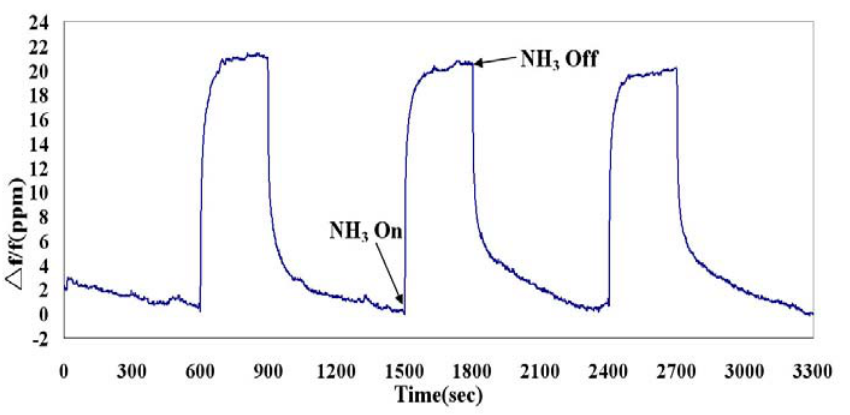
Figure 8. Frequency responses of the SAW sensor to 77 ppm